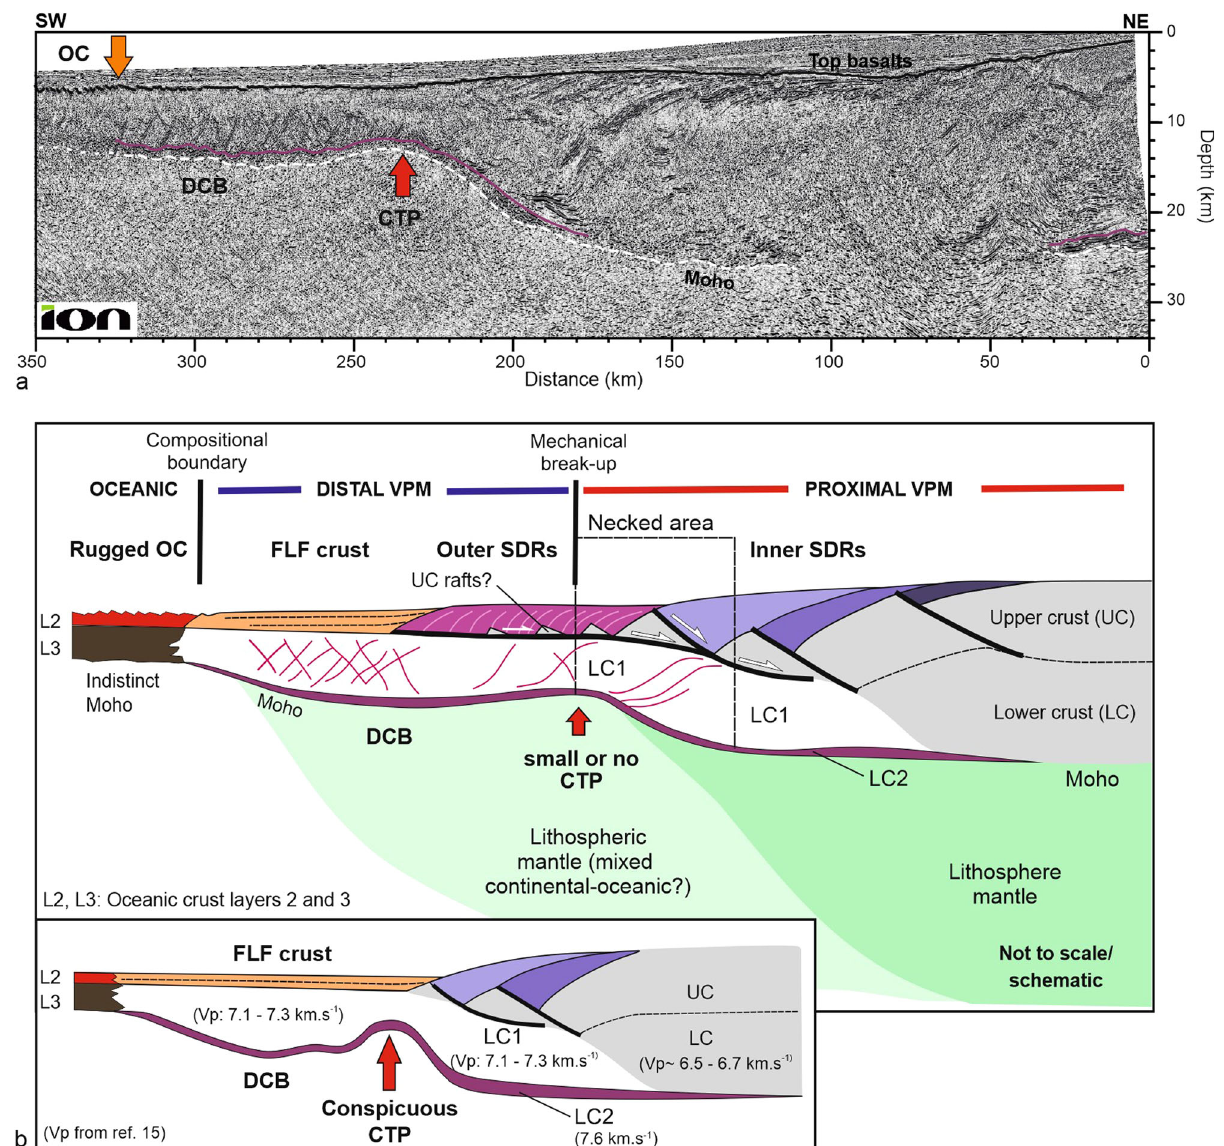
Fig. 3 Crustal structure of VPMs offshore Namibia. a Selected line with crustal thin point (CTP) and distal crustal bulge (DCB) (ION TM line VI, Fig. 2). b Synthetic VPM models from the studied seismic lines. Main drawing: VPM with outer-SDR and FLF crust types (lines II and III, Fig. 2). Infra: with FLF crust only (lines I and IV – X, Fig. 2). Full seismic velocities can be found in Supplementary Figs. 2 and